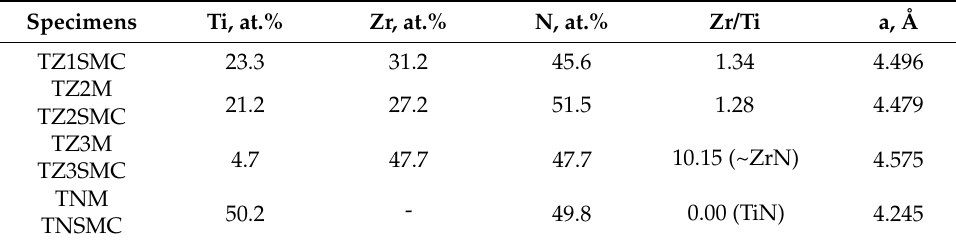
Table 2. Elemental composition of coatings and lattice parameters of δ —(Ti,Zr)N. Specimens Ti, at.% Zr, at.% N,